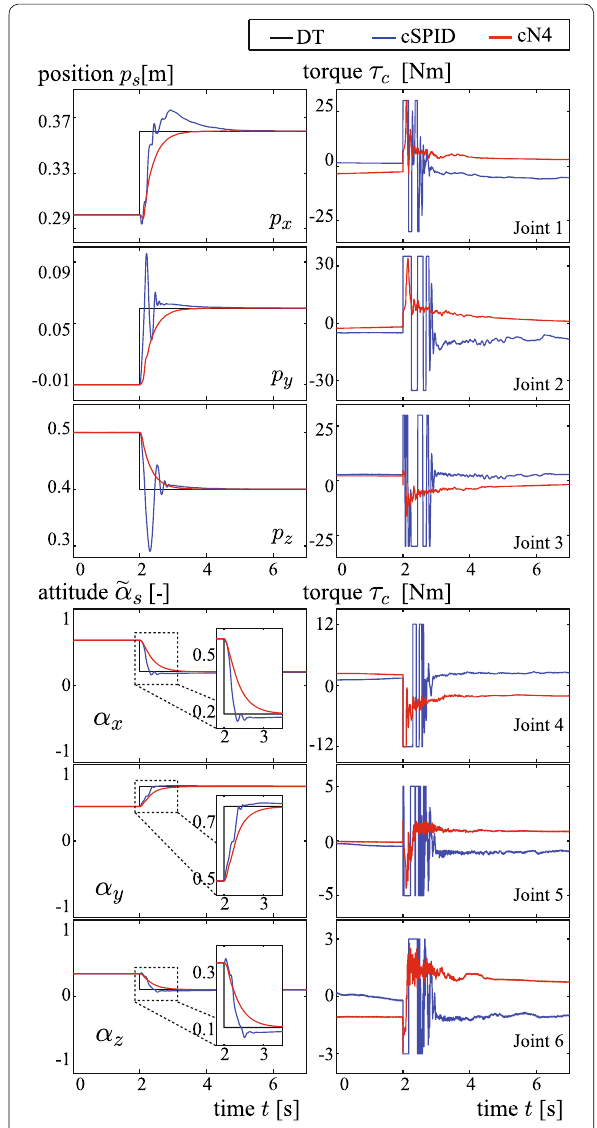
Fig. 7 Results of Experiment II. The end-effector position p s and attitude ˜ α s and each joint torque during set-point controllers under cN4 and cSPID where the desired trajectories DT are pointed in Fig.